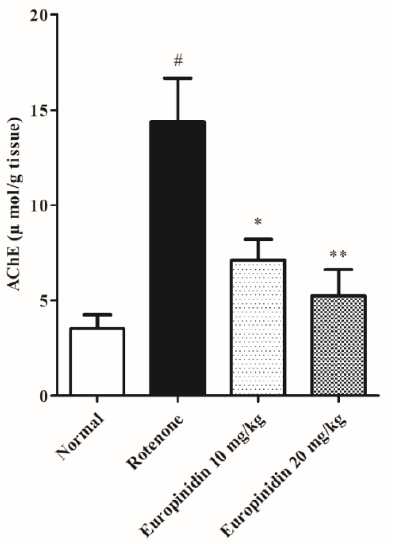
Figure 2. Effect of europinidin on antioxidant enzymes. ( A ) Superoxide dismutase (SOD), ( B ) Catalase (CAT), ( C ) Malondialdehyde (MDA), ( D ) Glutathione transferase (GSH). The data were expressed as mean ± S.E.M. ( n = 6/group). * p < 0.05, ** p < 0.01, *** p < 0.001 when compared with the control group; # p < 0.001 when compared with rotenone group (one-way ANOVA followed by Tukey’s test).